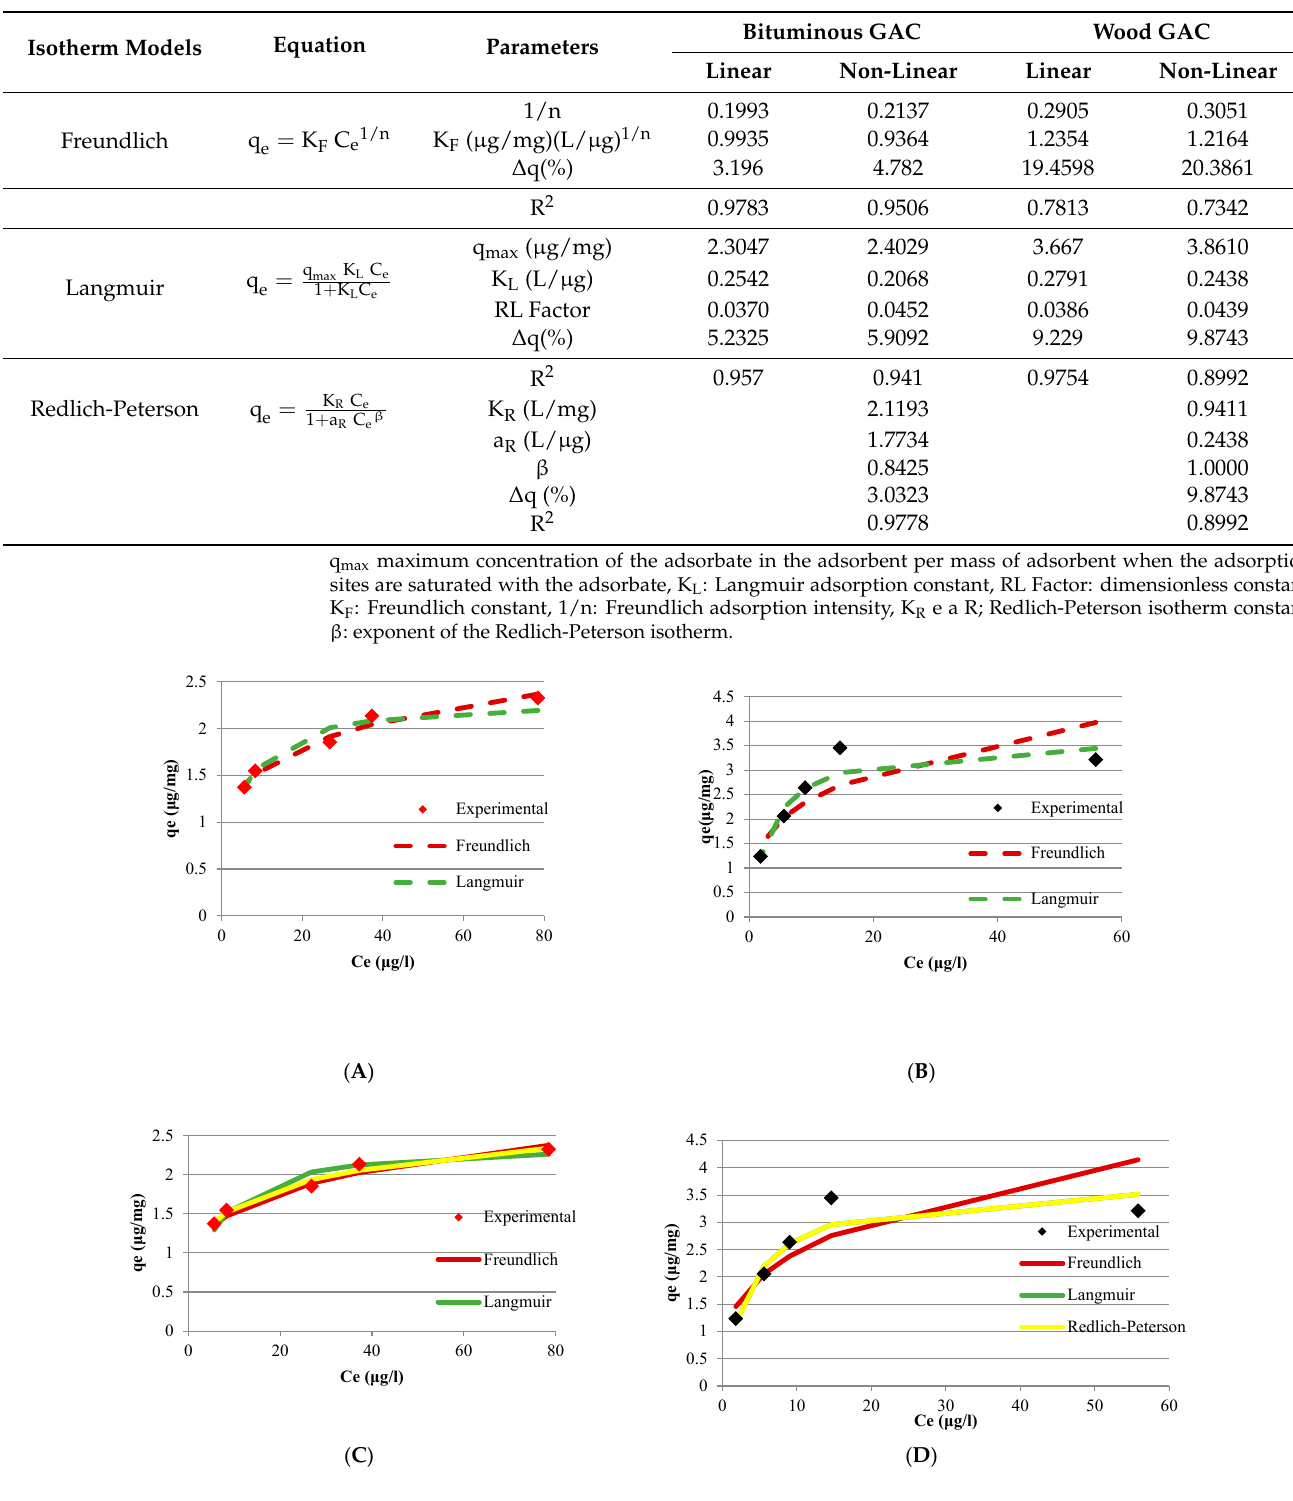
Table 4. Isotherm constants for the adsorption of CYN onto Bituminous and Wood carbons using Parano á lake water as matrix.